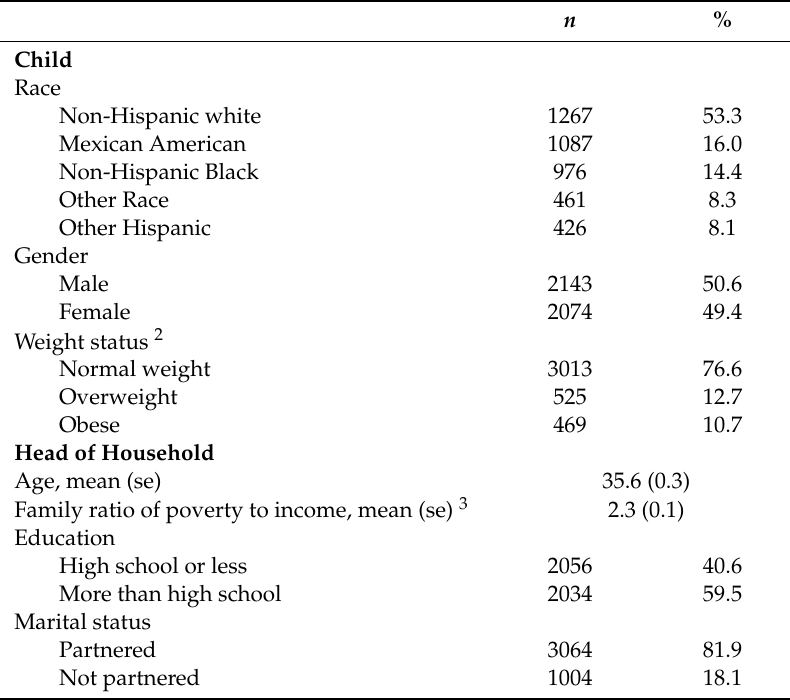
Table 1. Demographic characteristics ( n = 4217 1